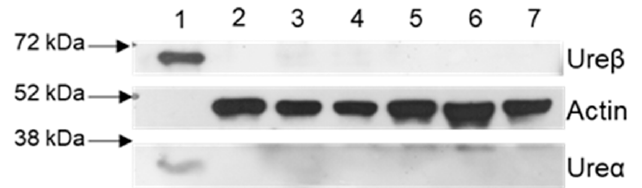
Figure 6. Blood–brain barrier integrity of rats treated with HPU. Male Wistar rats received i.p. injections of HPU for 7 days (5 µg/rat/day), and the same volume of sterile saline was administered to the control groups. Hippocampal homogenates from three independent experiments (G1, G2, G3), each composed of a treated group and a control group (N = 4), were analyzed by Western blot assays using antibodies against HPU subunit B (ure β ) and subunit A (urea) (60 kDa and 30 kDa, respectively). The figure illustrates a typical blot, with controls in lanes 2, 4 and 6, and HPU-treated groups shown in lanes 3, 5 and 7. Purified HPU protein (25 µg) is seen in lane 1.